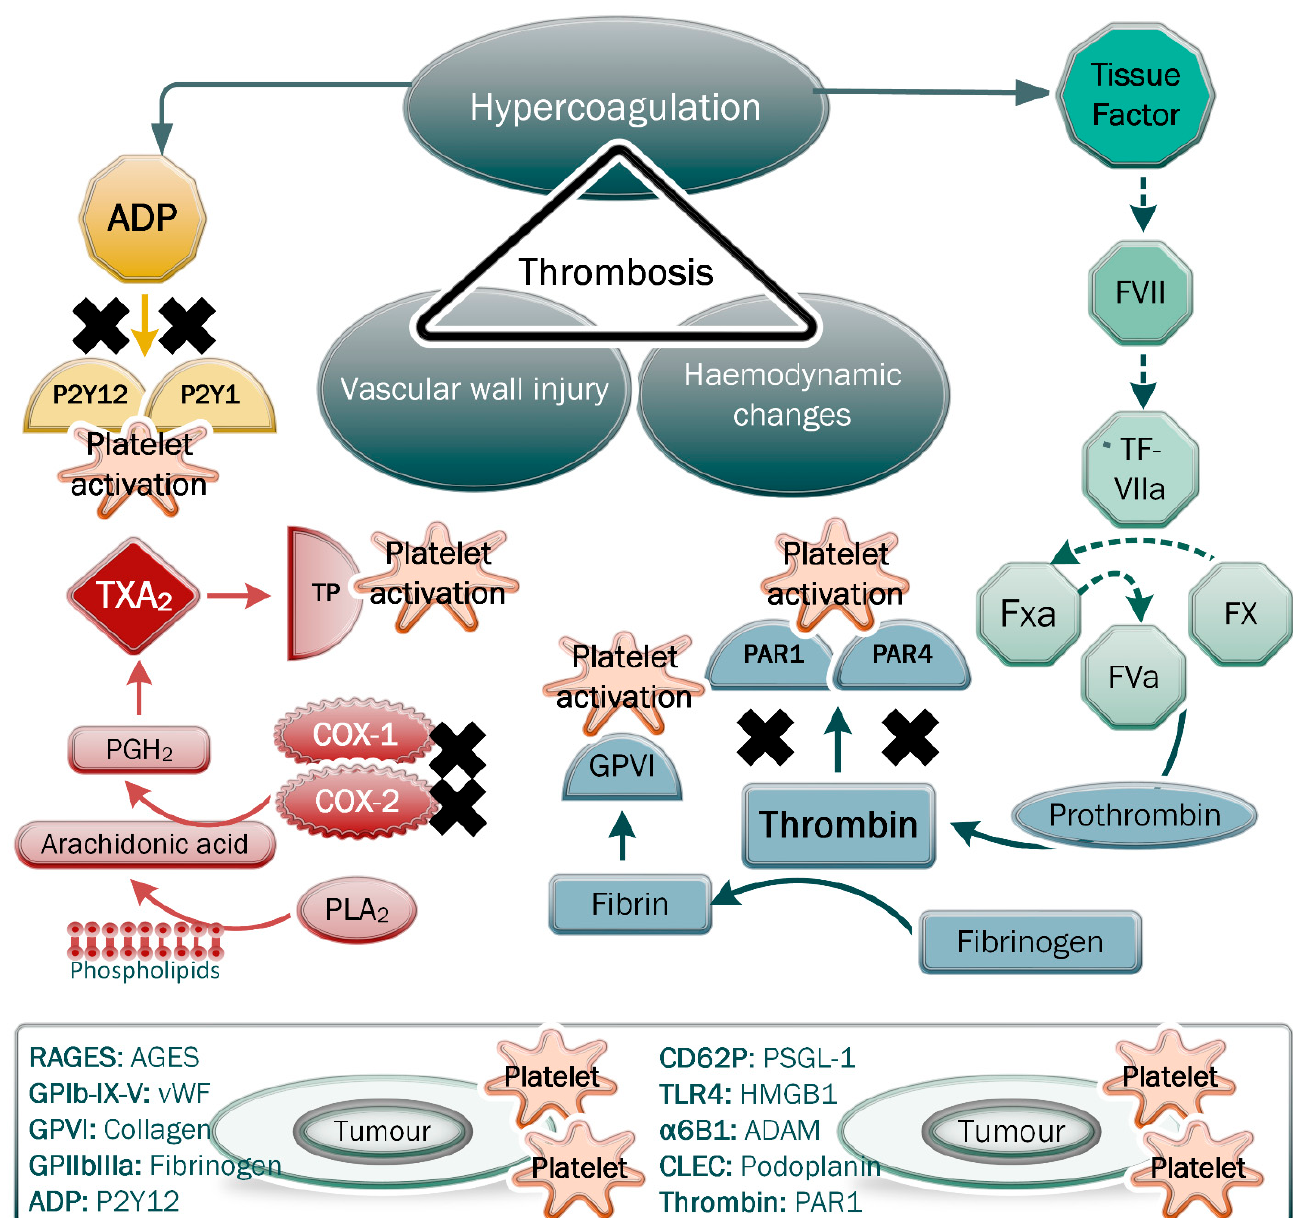
Figure 1. Virchow’s triad showing the main parameters of thrombosis. Regarding hypercoagulation, note the effects of the secreted platelet agonist tissue factor, ADP, thrombin and thromboxane A 2 on the pathways inducing platelet activation and fibrin formation. Tumour cells are able to secrete these platelet agonists, which, following induction of platelet activation, cause the release of micro ‐ particles and a host of factors that can facilitate tumour progression and thrombotic